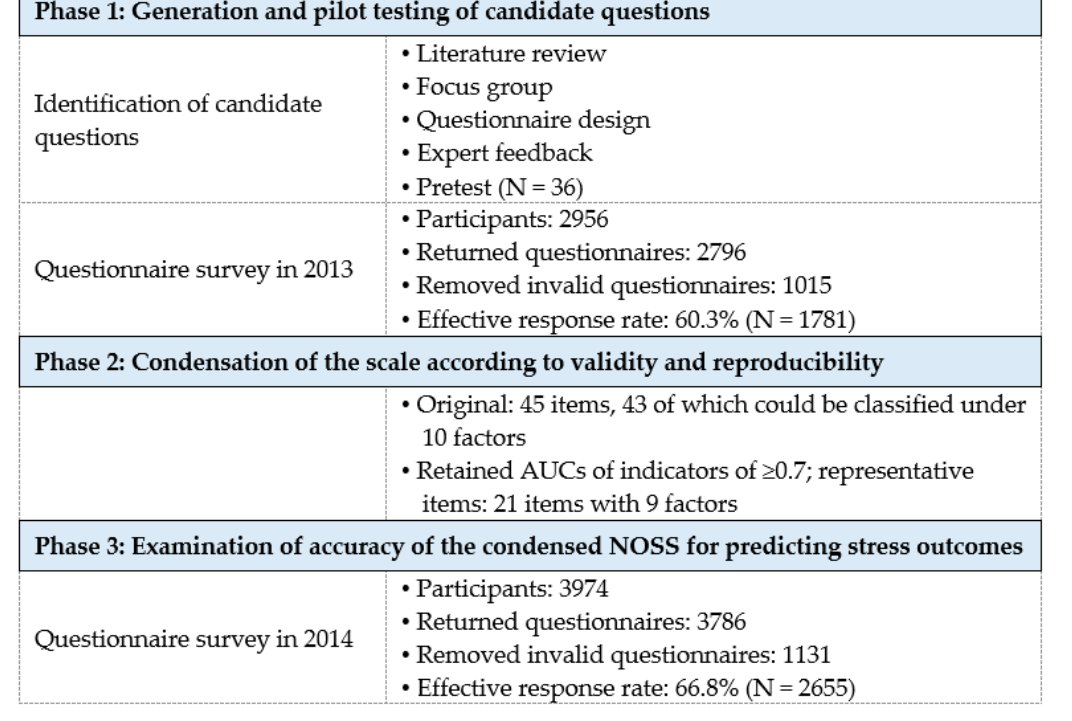
Figure 1. The process of the NOSS development.